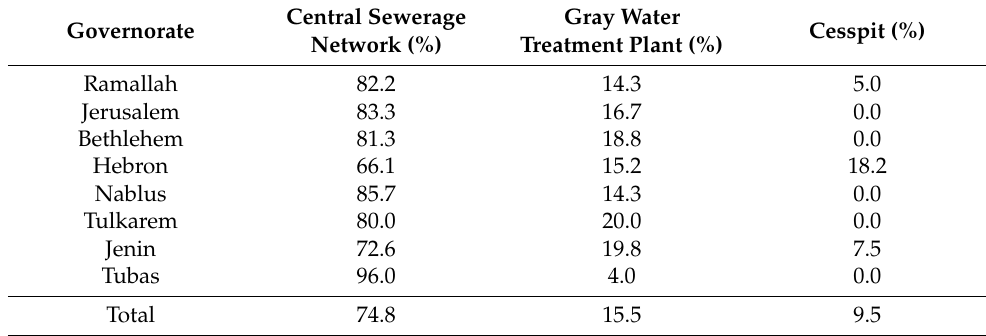
Table 1. Preferred systems of sanitation per governorate.